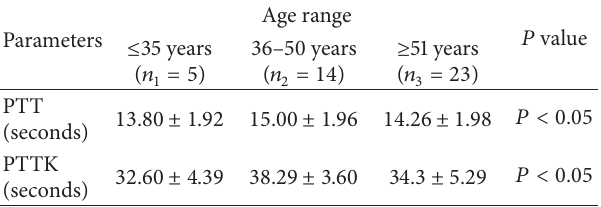
Table 3: Comparison of the prothrombin time test (PTT) and partial thromboplastin time test kaolin (PTTK) across ages